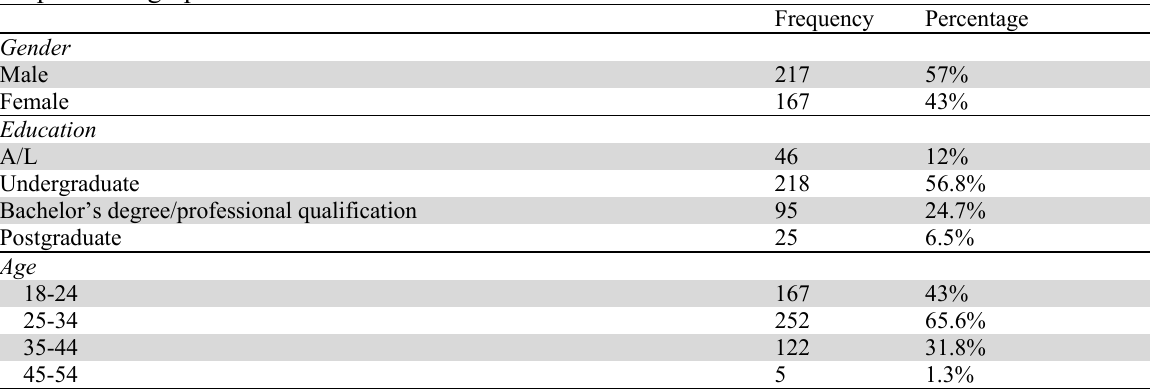
Sample Demographics